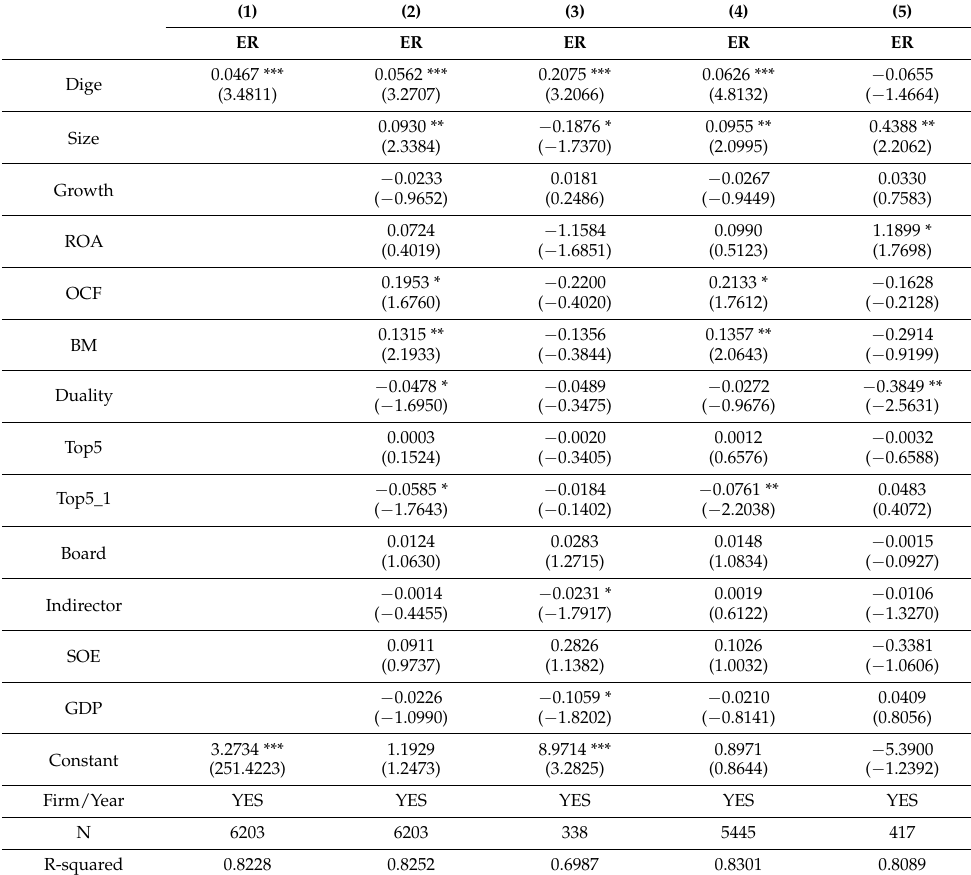
Table 3. Digital economy development and corporate energy conservation and emission